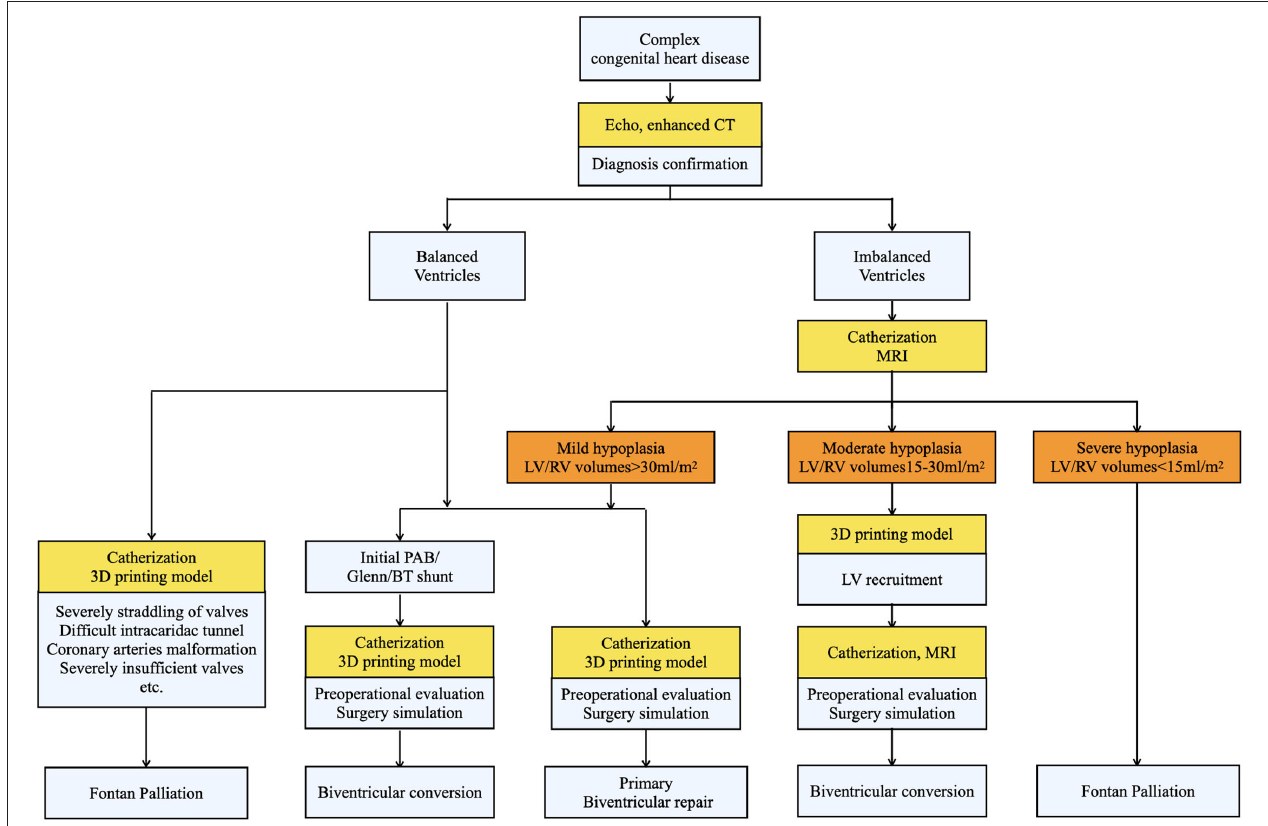
FIGURE 1 | The surgical decision-making process of biventricular conversion in our center. Patients were classified into balanced and imbalanced groups after being diagnosed by echocardiography and enhanced CT. Then various evaluations (shown in yellow) were conducted to determine the feasibility of biventricular correction and different strategies were accordingly